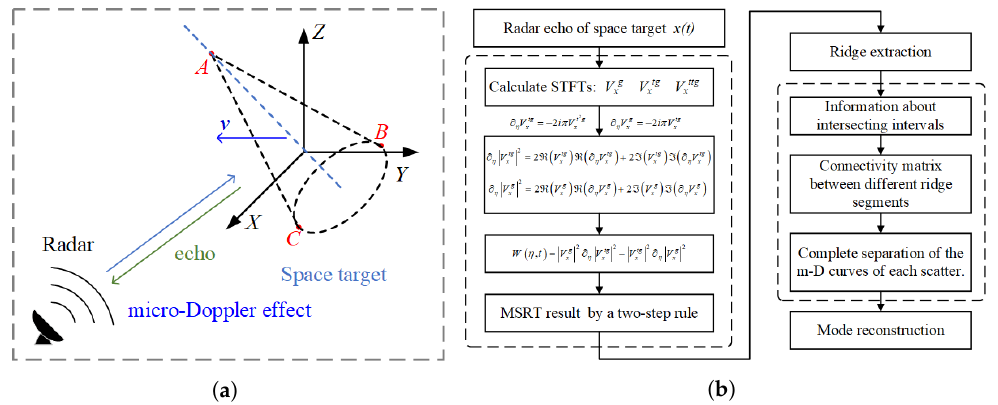
Figure 3. Detection scene and signal processing flow. ( a ) Detection scene of space target with three scattering centers A, B and C. ( b ) Processing